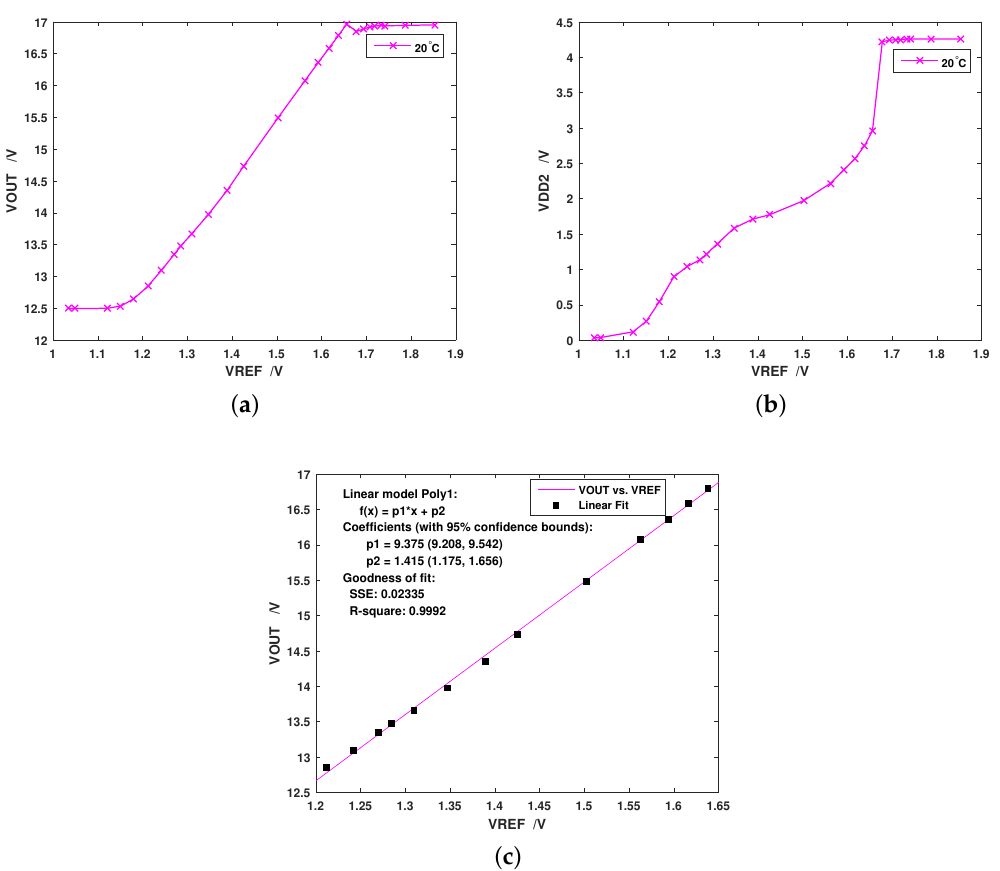
Figure 8. Measured output of the charge pump at 20 ◦ C: ( a ) the tested graph of output vs. reference voltage; ( b ) the tested controller voltage V DD 2 vs. reference; and ( c ) regression of the linear interval in ( a